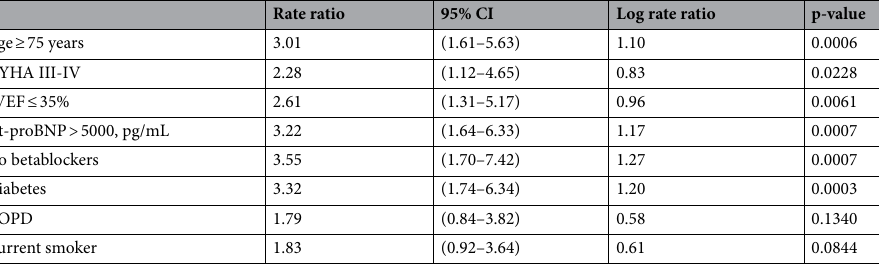
Table 3. Multivariate analysis. Piecewise constant exponential model. CI confidence interval; COPD chronic obstructive pulmonary disease; LVEF left-ventricular ejection fraction; Nt-proBNP Nt-pro brain natriuretic peptide; NYHA New York Heart Association.